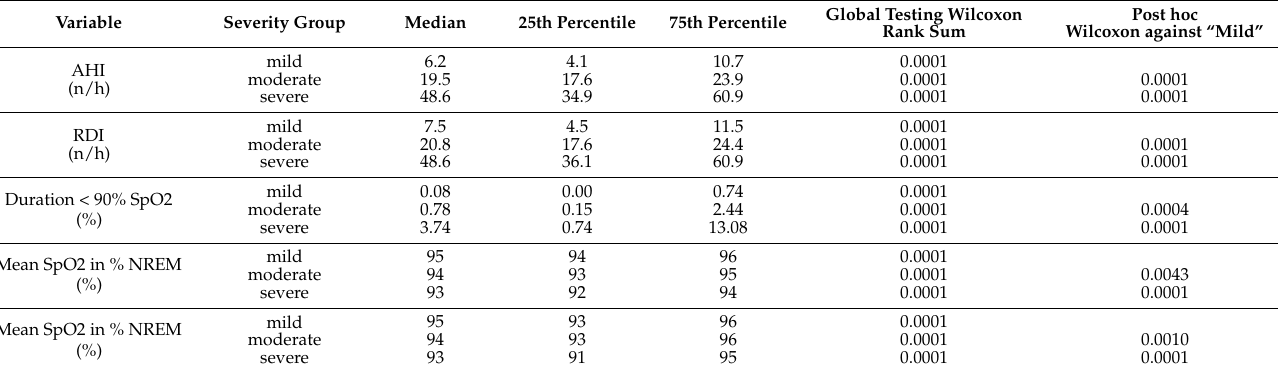
Table 2. The epidemiological data of the 141 patients divided in the severity groups (mild, moderate, and severe) showing the variables AHI in number per hour, Respiratory Disturbance Index (RDI) in number per hour, duration of SpO2 < 90% as a percentage of TST, mean SpO2 in NREM as a percentage, and mean SpO2 in REM as a percentage. Besides the grouping, the median with 25/75 percentile is shown. To test for significance, the Wilcoxon rank-sum test as well as the post hoc Wilcoxon test was used. We compared the moderately and severely affected groups against the mildly affected